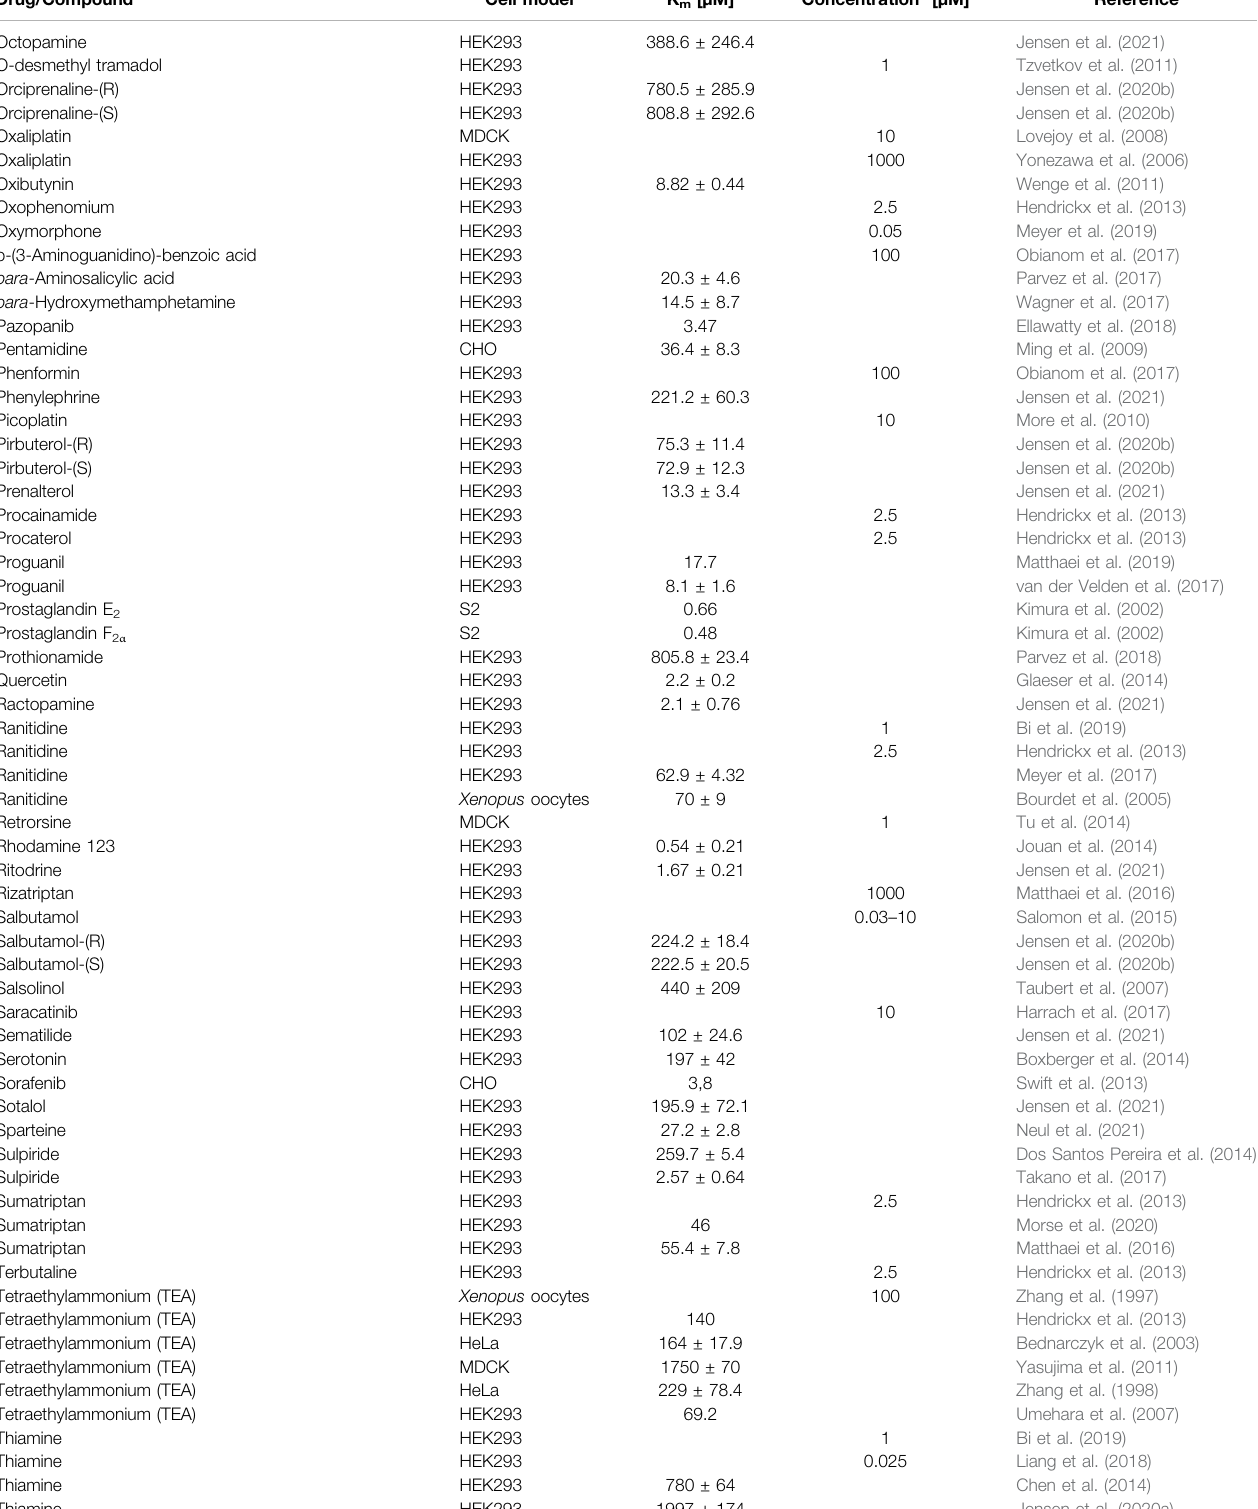
TABLE 1 | ( Continued ) Substrates of OCT1 (drugs, drug metabolites, endogenous molecules, chemicals) studied in single-transfected cell